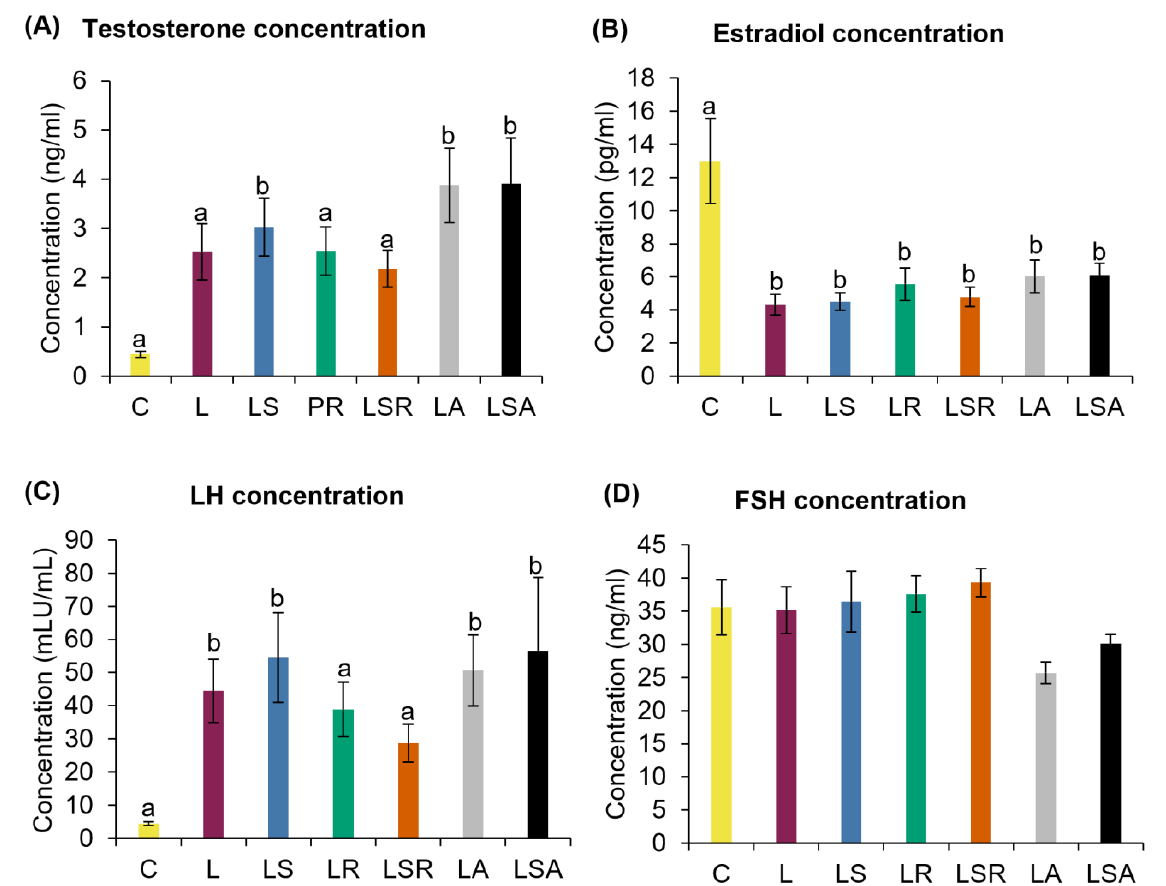
Figure 4. Analyses of reproductive hormones. Biochemical analyses of reproductive hormones; ( A ) testosterone, ( B ) estradiol and pituitary hormones; ( C ) LH and ( D ) FSH. These hormones were measured in the serum samples of the rats using the respective ELISA kits. All the values are expressed as the mean ± S.E. Statistical analysis was conducted by one-way ANOVA followed by Dunnett’s test for multiple comparison analysis. a, b represent p < 0.05 compared to the C group.